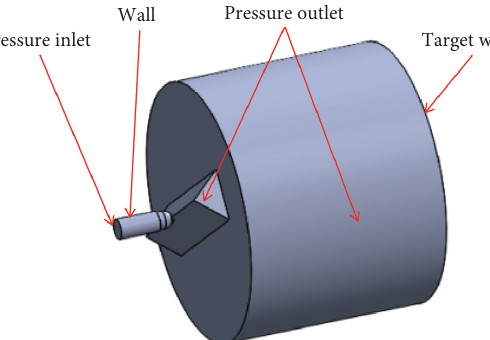
Figure 3: 3D model of nozzle and external flow